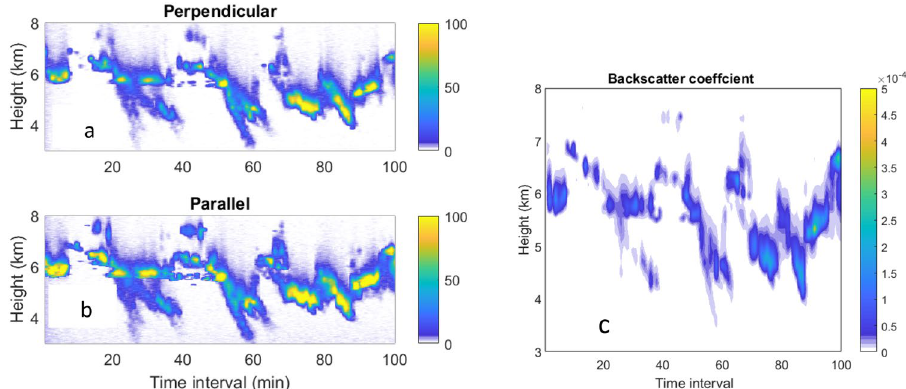
Figure 3. (left) Aerosol layers measured by lidar at Kaohsiung in signals of perpendicular ( a ) and parallel ( b ) polarization channels, time starting 18:04 LT. ( c )The backscattering coefficients in unit of (1/m-sr) measured on Feb 11.